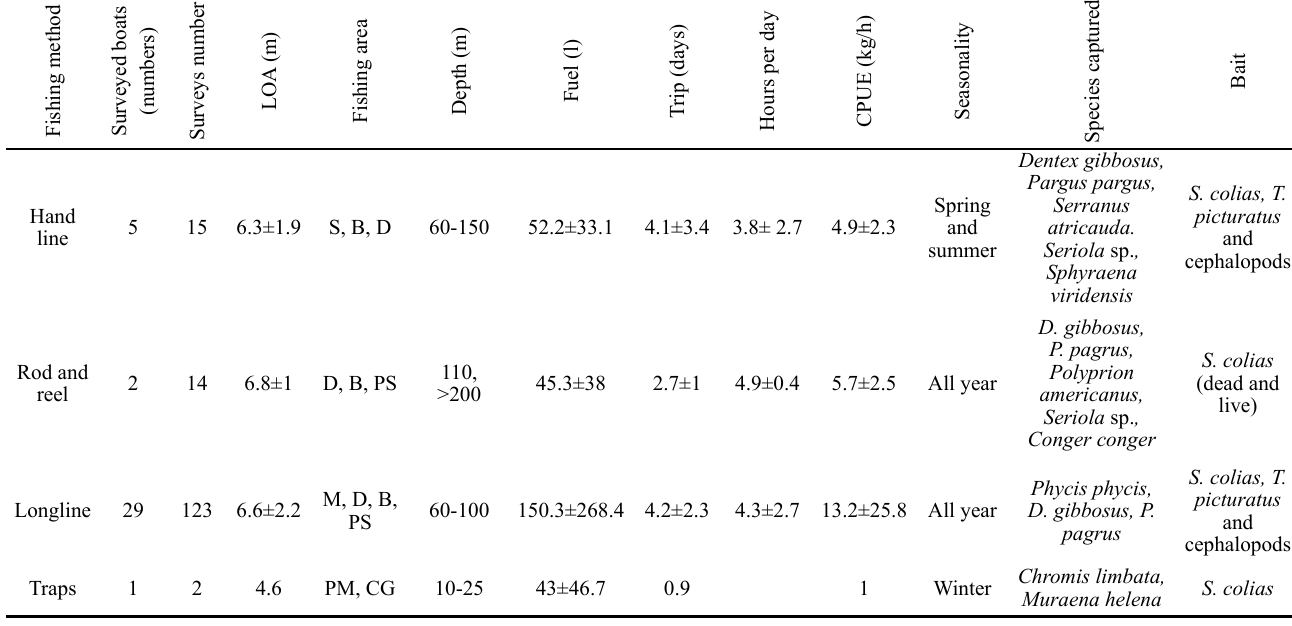
Table 1. – Artisanal fishing techniques and characteristics (number of interviewed boats, number of surveys, LOA, usual fishing areas S, South; B, Barlovento; D, Desertas; PS, Porto Santo; M, Madeira; PM, Paul do Mar; CG, Cabo Girão), fishing depth range, fuel expense, duration of the fishing trip, CPUE, seasonality and main target species). The data are shown as number or average